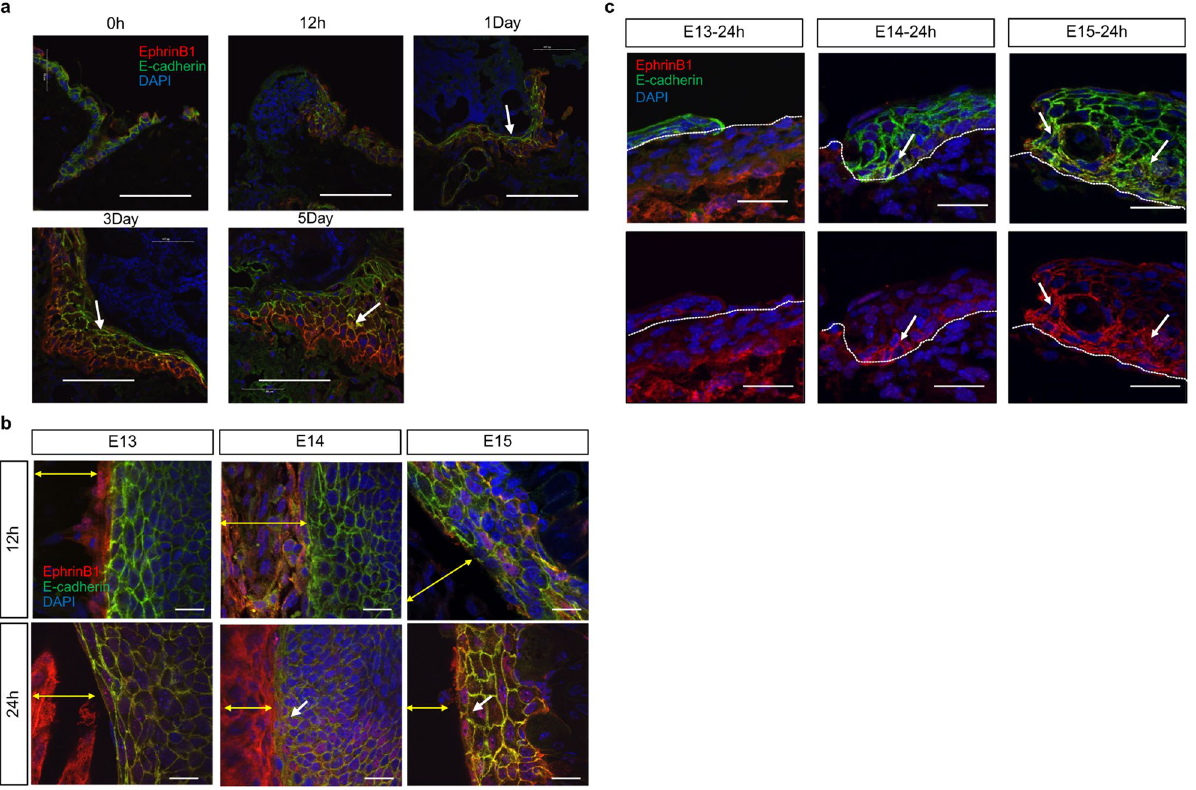
Figure 5. Relationship between ephrin-B1 and E-cadherin during wound healing. In E13 wounds, ephrin-B1 did not reduce E-cadherin levels. However, after E14, ephrin-B1 localized to the cell membrane and disassembled E-cadherin, suggesting a transition to cell migration-type wound healing. ( a ) Wounds in adult mice, Scale bar = 50 µm. ( b ) Whole-mount samples from fetal mice. Yellow arrow: wound. Scale bar = 20 µm. ( c ) Vertical section of the fetal wound. Scale bar = 30 µm, with arrows indicating areas of reduced E-cadherin expression. Dashed line: boundary between epidermis and